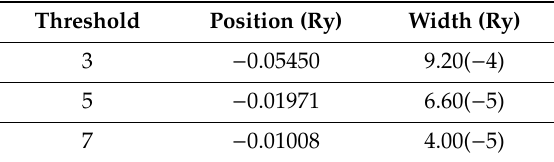
Table 20. Odd parity triplet P states of a Ps − ion.